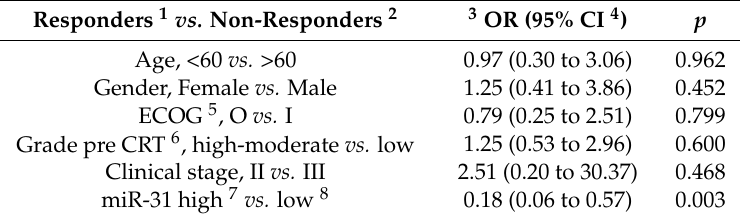
Table 3. Multivariable logistic analysis for miR-31 expression measured pre neoadjuvant CRT and the rest of clinic-pathological factors measured before neoadjuvant CRT in responder and non-responder